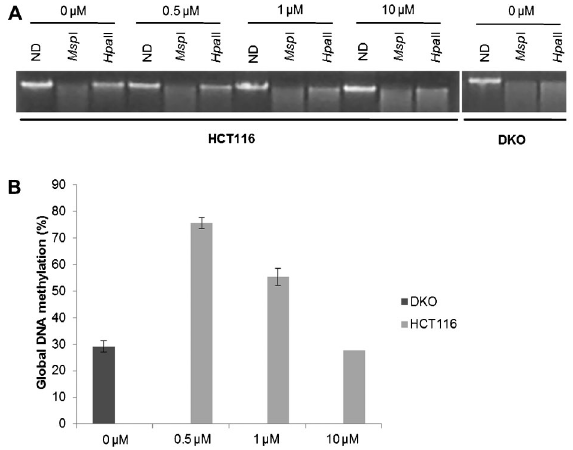
Figure 1. Global DNA methylation analysis. A , One percent agarose gel staining with ethidium bromide showing non-digested DNA (ND) and DNA digested with Msp I or Hpa II, which is an isoschizomer of Msp I methylation sensitive enzyme, at different media concentrations of 5-aza-2 9 -deoxycytidine (5-aza-CdR; 0, 0.5, 1.0, and 10 m M). B , Percentage of DNA methylation of each 5-aza-CdR treatment condition and DKO cells in relation to basal methylation of the HCT116 cell line (data from 2 different